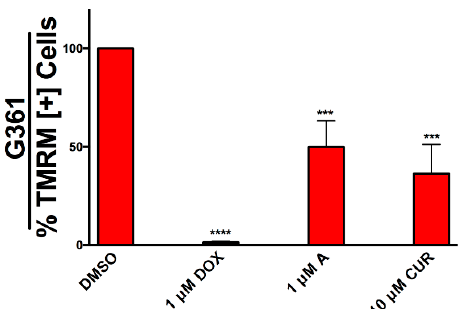
Figure 7. Mitochondrial depolarization in G361 cells undergoing apoptosis. G361 cells were treated with Compound A and curcumin for 48 h followed by incubation with TMRM for 45 min to quantify mitochondrial membrane potential (MMP), as described in the materials and methods section. Results were obtained using image-based cytometry with the y -axis representative of percent of cells positive for TMRM expressed as a mean ± SD from three independent experiments. Doxorubicin (DOX) was used as a positive control. A = Compound A, CUR = Curcumin. *** p < 0.001 vs. TMRM [ + ] cells of DMSO control; **** p < 0.0001 vs. TMRM [ + ] cells of DMSO control.